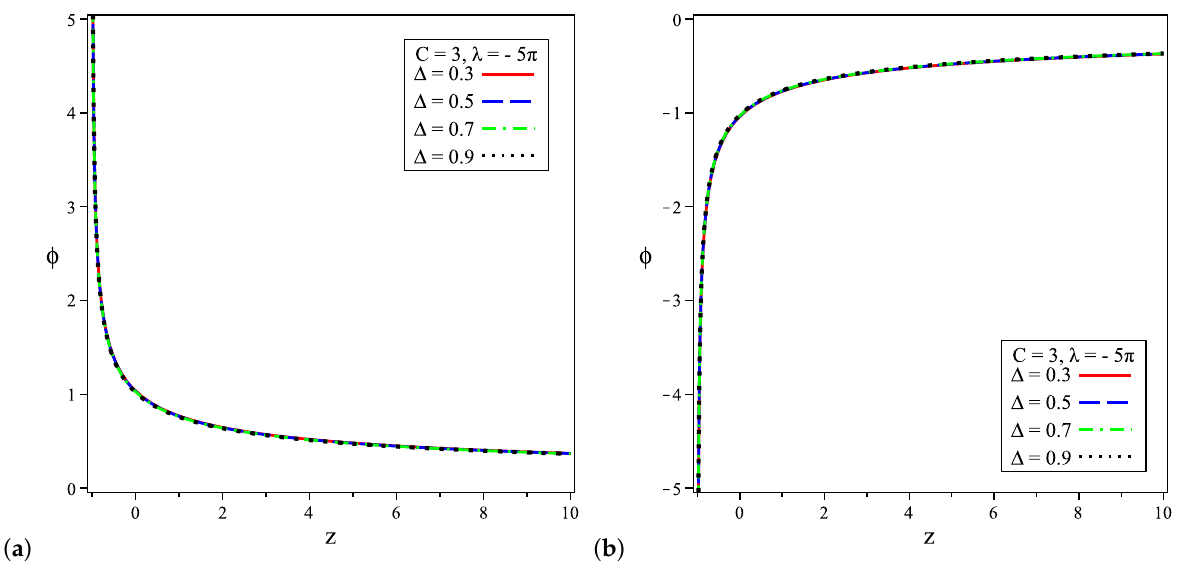
Figure 4. Depicting the nature between the redshift ( z ) and the Barrow holographic k essence: ( a ) ( φ ) is positive and ( b ) ( φ ) is negative; here, C = 3 and λ = − 5 π .